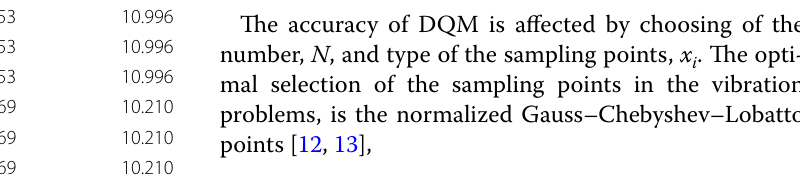
Table 1 Comparison between present DQM, PM, and analytical values for the first three non-dimensional frequencies of uniform beams Non-dimensional frequency